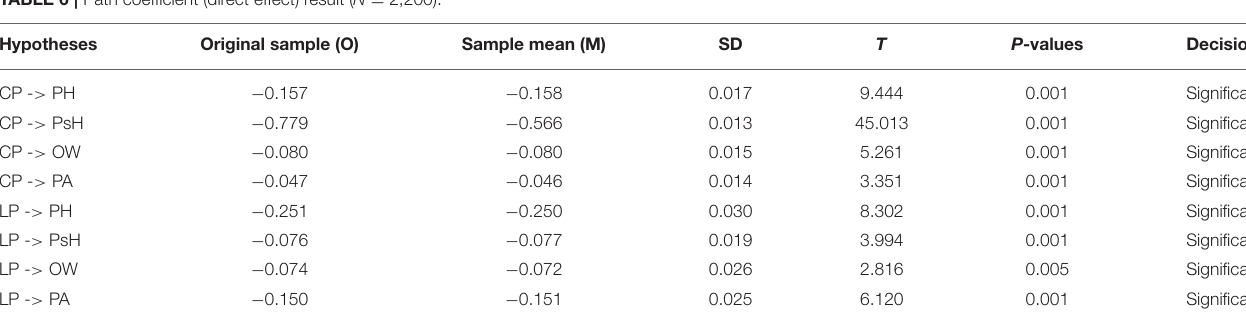
TABLE 6 | Path coefficient (direct effect) result ( N =